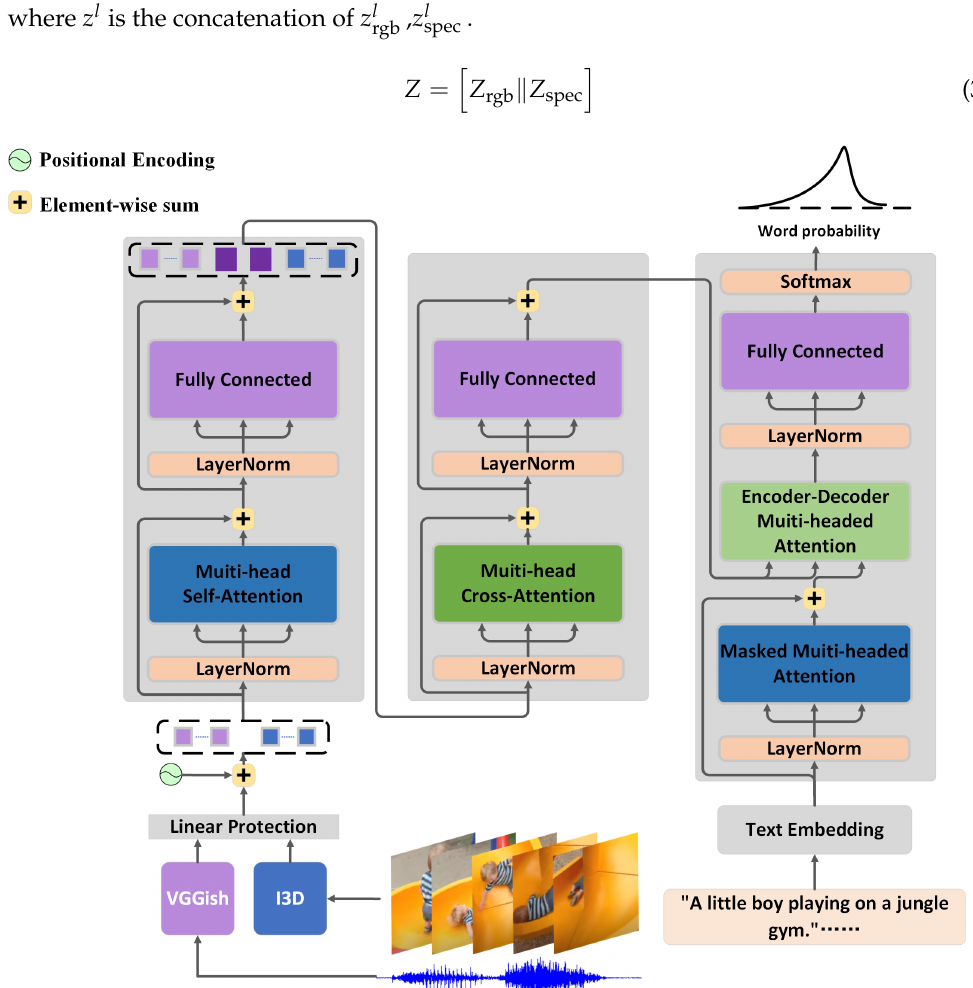
Figure 1. Video captioning generation using visual and audio modes can more accurately generate complex traffic scene videos. We use the attention bottleneck module for modal fusion.